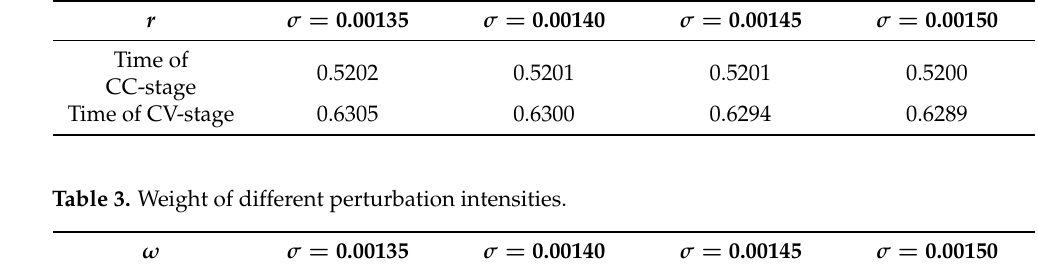
Table 2. Reliability of different perturbation intensities.